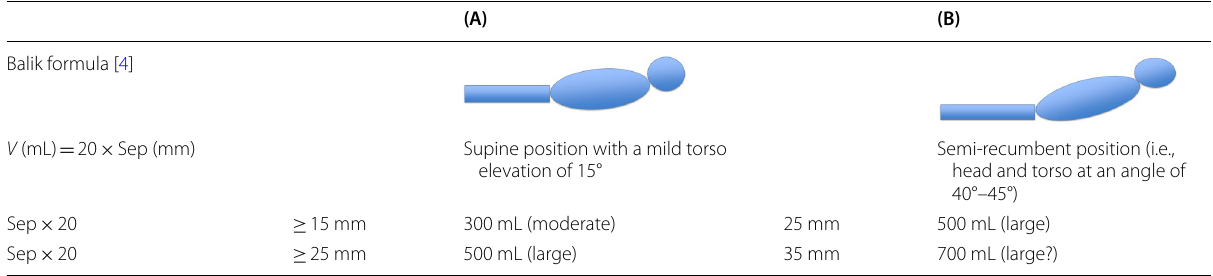
Table 1 An example of a possible relationship between the patient position and the estimation of volume of pleural fluid (mL) with maximum separation at lung base (Sep—mm), assuming an increase of 1 cm from A to